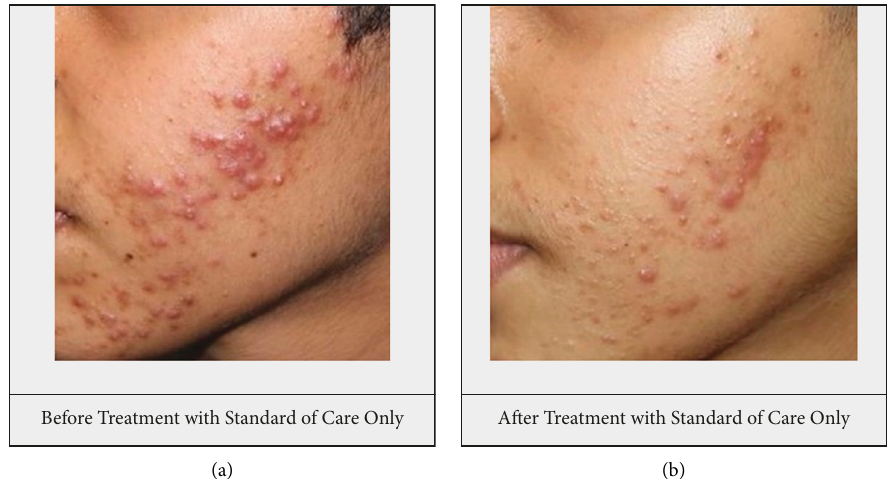
Figure 8: Treatment with standard of care alone did not result in a significant reduction in the number of acne lesions or acne severity. Table 3: Percentage change in the total, inflammatory, and noninflammatory acne lesion counts. Group A Group B